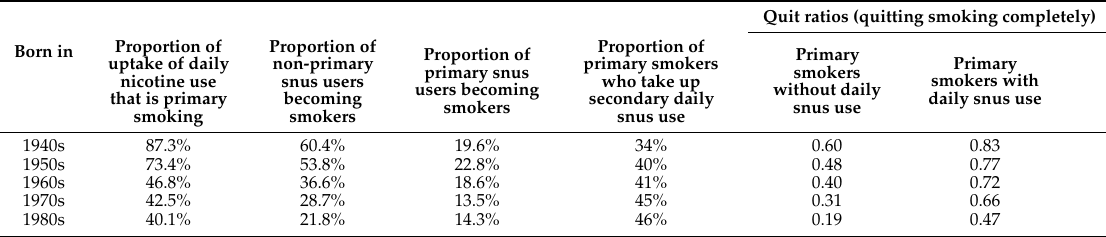
Table 2. Occurrence and effects of secondary snus use in different birth cohorts of men in Sweden.